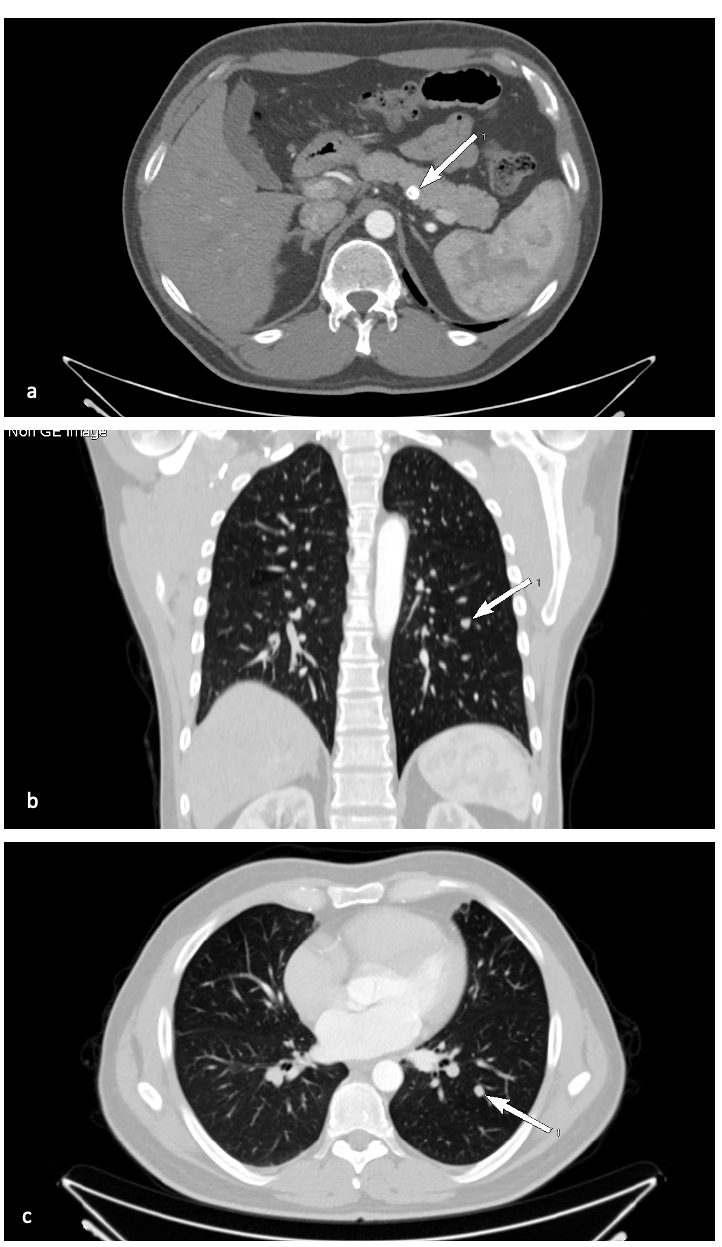
Figure 4. Radiological presentation of patient III.4 in the pedigree. Transverse CT image of pancreas with calcifications ( a ) and lung metastasis in axial ( b ) and transverse ( c ) CT (arrows). In November 2017, ( 68 Ga) Ga-DOTATATE PET/CT was performed. It revealed multiple focal accumulations of the tracer in the pancreas, with the most prominent one observed within the pancreatic corpus (SUVmax 22.8), located in the topography of a previously described calcified tumor, and a probable metastasis in the left lung (SUVmax 6.54). In January 2018, due to dissemination of the neuroendocrine tumor, treatment with Lanreotide autogel at 120 mg s.c./4 weeks was initiated with good patient tolerance. In December 2018, an endoscopic ultrasound was performed. Histopathological examination of the samples revealed the presence of a probable neuroendocrine tumor (synaptophysin+, chromogranin+). In January 2020, follow-up CT revealed a partial regression of the pancreatic lesions, while the pancreatic neuroendocrine tumors and metastatic lung lesion were stable with no further progression (Figure 4b,c). Careful follow-up has been scheduled. Non-endocrine manifestations were seen as multiple cutaneous